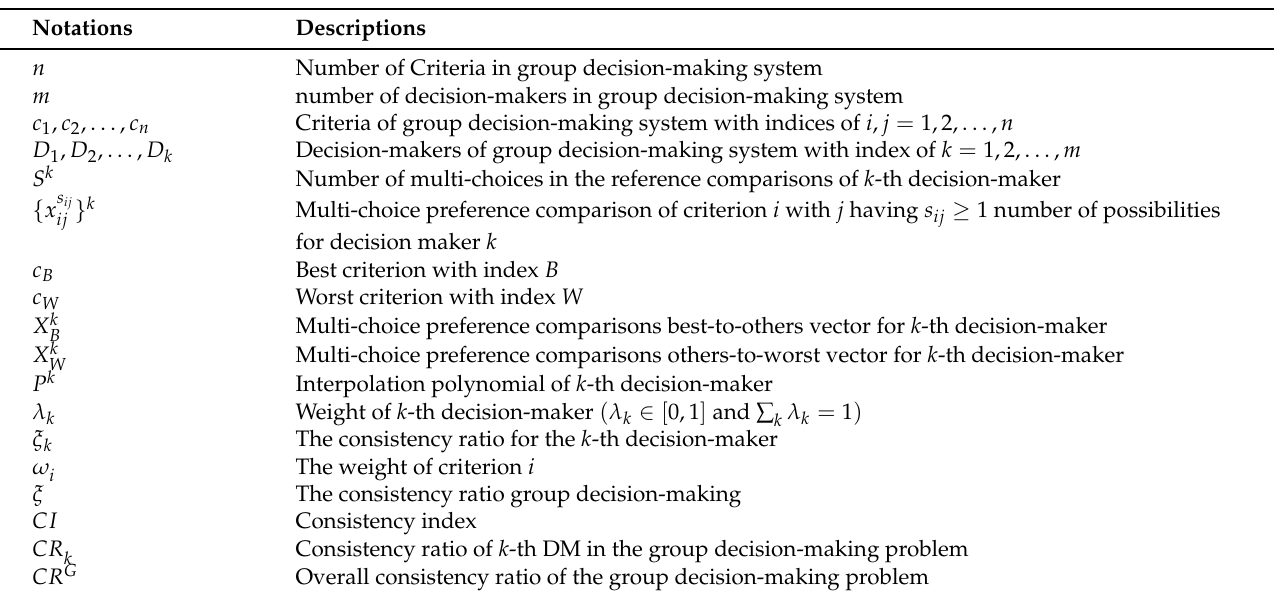
Table 2. Symbols/Notations used in this